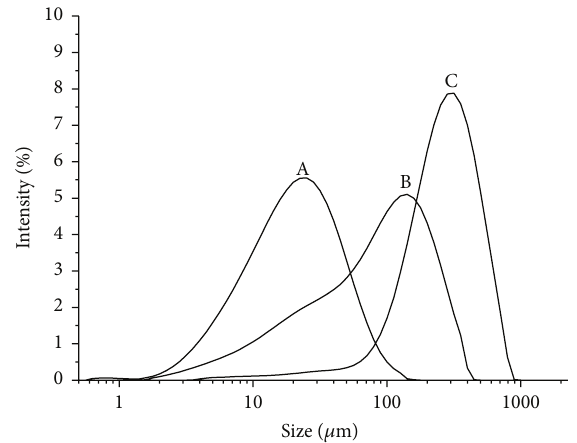
Figure 1: Particle size distributions of the IDF fraction powder: (A) ball milled IDF fraction, (B) ultra centrifugal milled IDF fraction, and (C) regular milled IDF fraction.